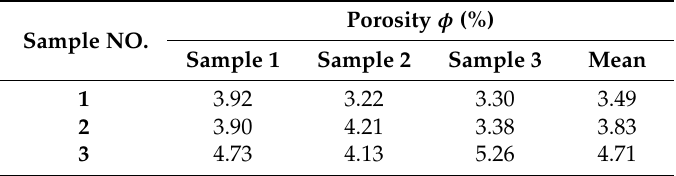
Table 3. Porosity of concrete.